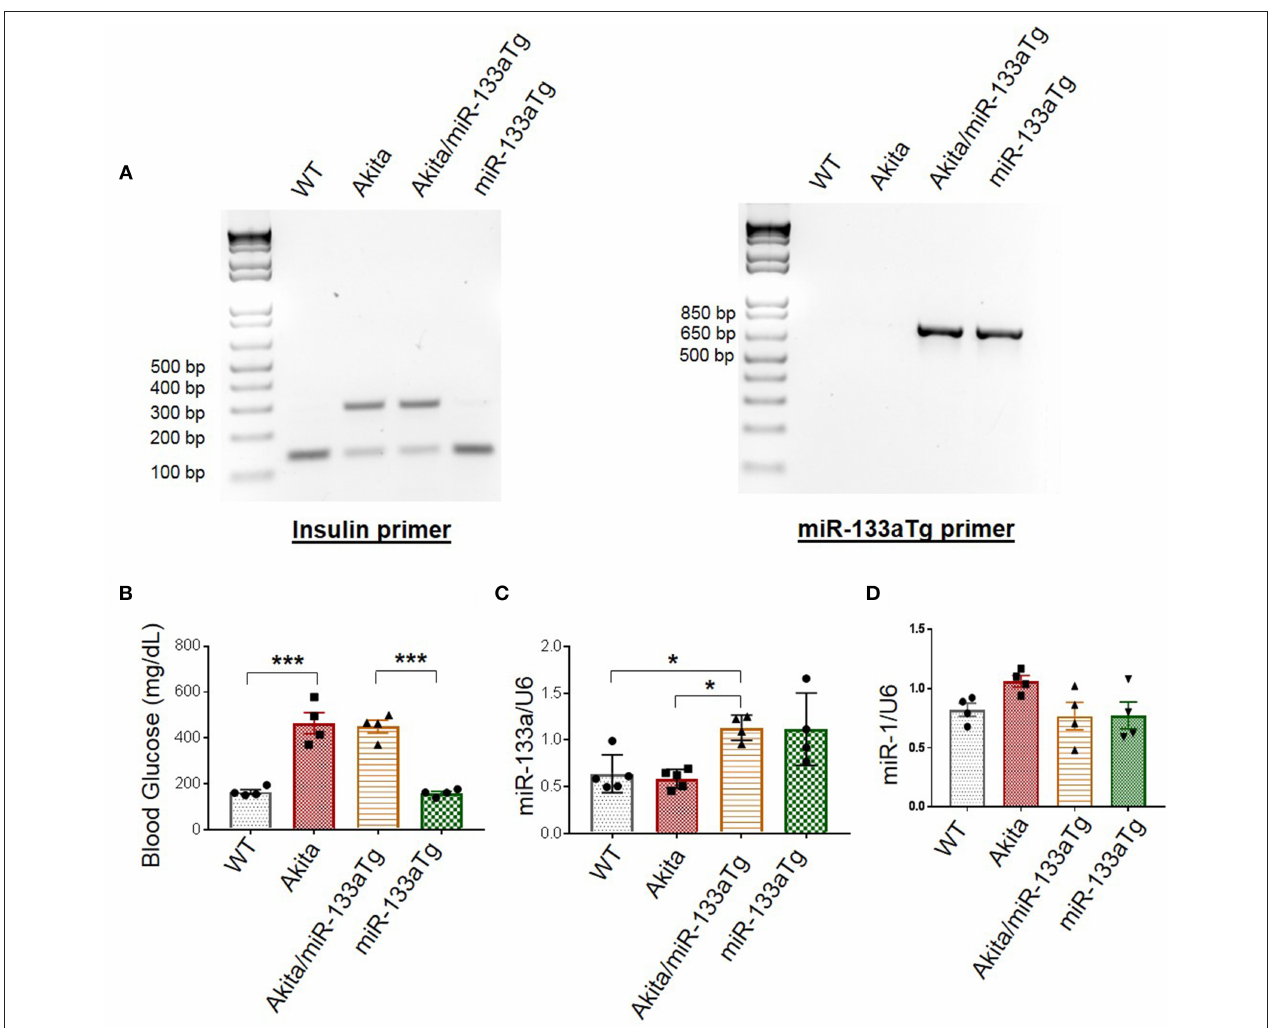
FIGURE 2 | Validation of Akita/miR-133aTg mice. (A) Genotyping for WT, Akita, Akita/miR-133aTg, and miR-133aTg mice with Insulin 2 and miR-133aTg primers. There were two bands in Akita (Insulin 2 heterozygous) at 140 and 280 bp. There was one band for the miR-133aTg at 670 bp. (B) Blood glucose levels for WT, Akita, Akita/miR-133aTg, and miR-133aTg mice. There was no significant change in the blood glucose levels of Akita and Akita/miR-133aTg. (C) Gene expression levels of miR-133a isolated from the left ventricle of WT, Akita, Akita/miR-133aTg, and miR-133aTg hearts. (D) miR-1 quantification by individual miR-1 assay. Values are presented as mean ± SEM. One-way analysis of variance (ANOVA) followed by Tukey’s test was used for statistical significance. N = 4–5 per group. * P < 0.05; *** P <